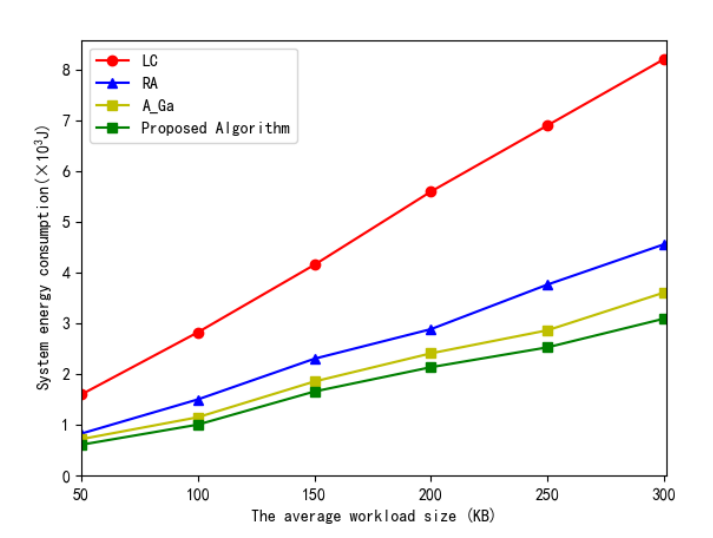
Figure 12. The total system energy consumption versus the average workload